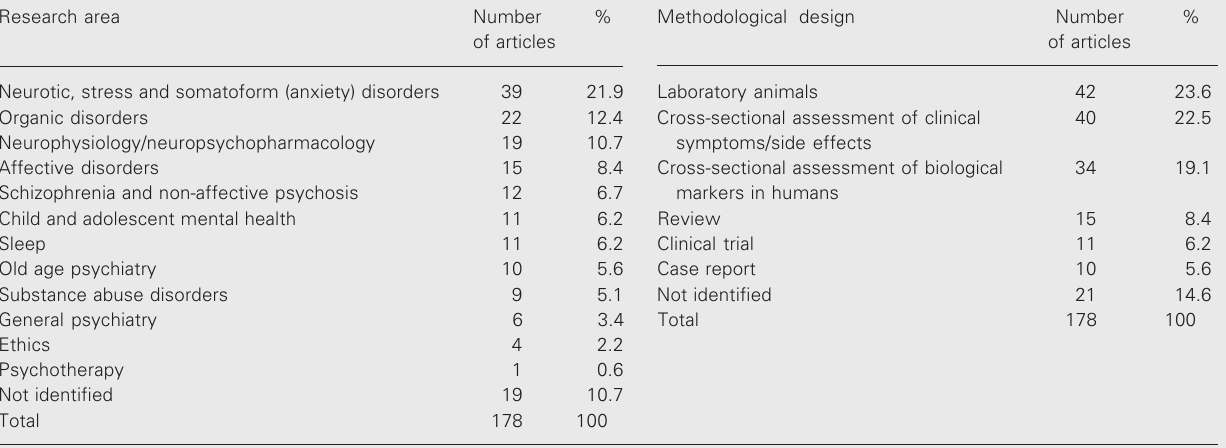
Table 4. Content and methodological design of the articles published in Psychiatry and related areas during 2002.